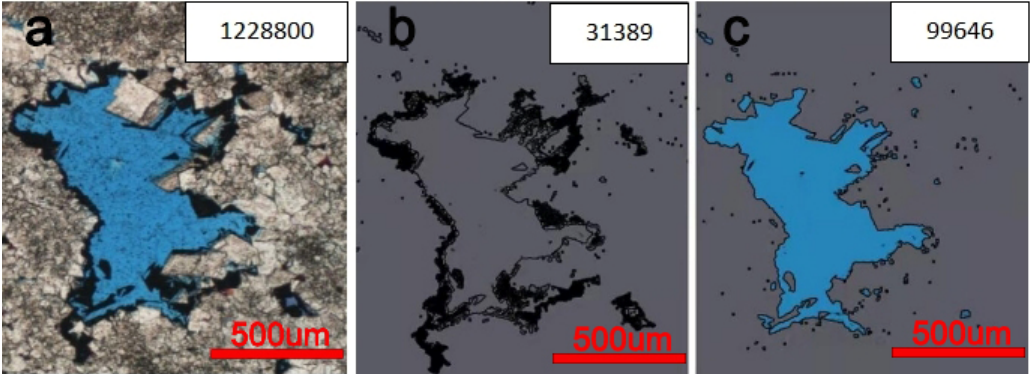
Figure 4. Pixel values of the cast thin section at a depth of 1885.4 m in Well Shutan 1: ( a ) thin section; ( b ) bitumen; ( c ) pores.